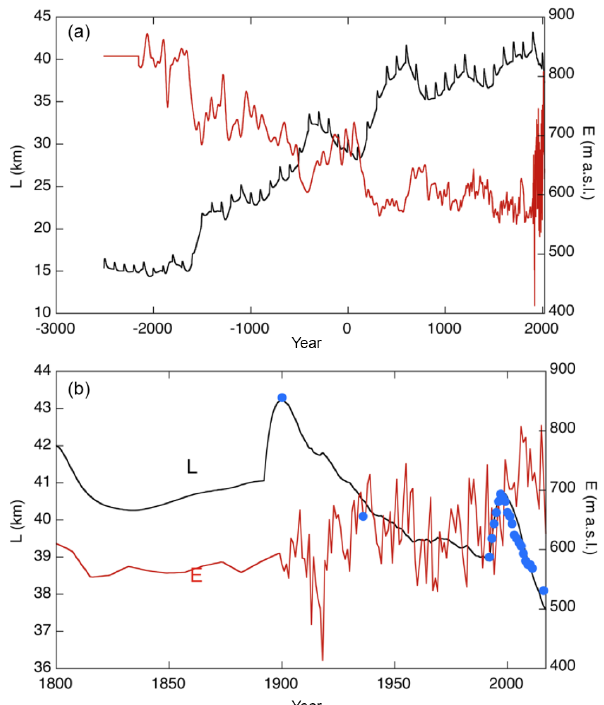
Figure 6. (a) Evolution of glaciers length L (black) as a response to the reconstructed equilibrium-line altitude E (in red); (b) close-up of the period 1800–2016. Observed glacier stands are shown as blue